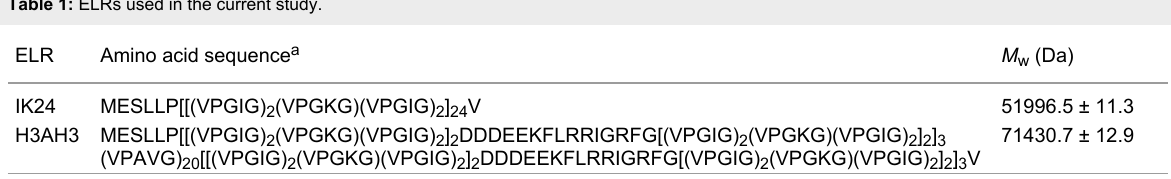
Table 1: ELRs used in the current study.